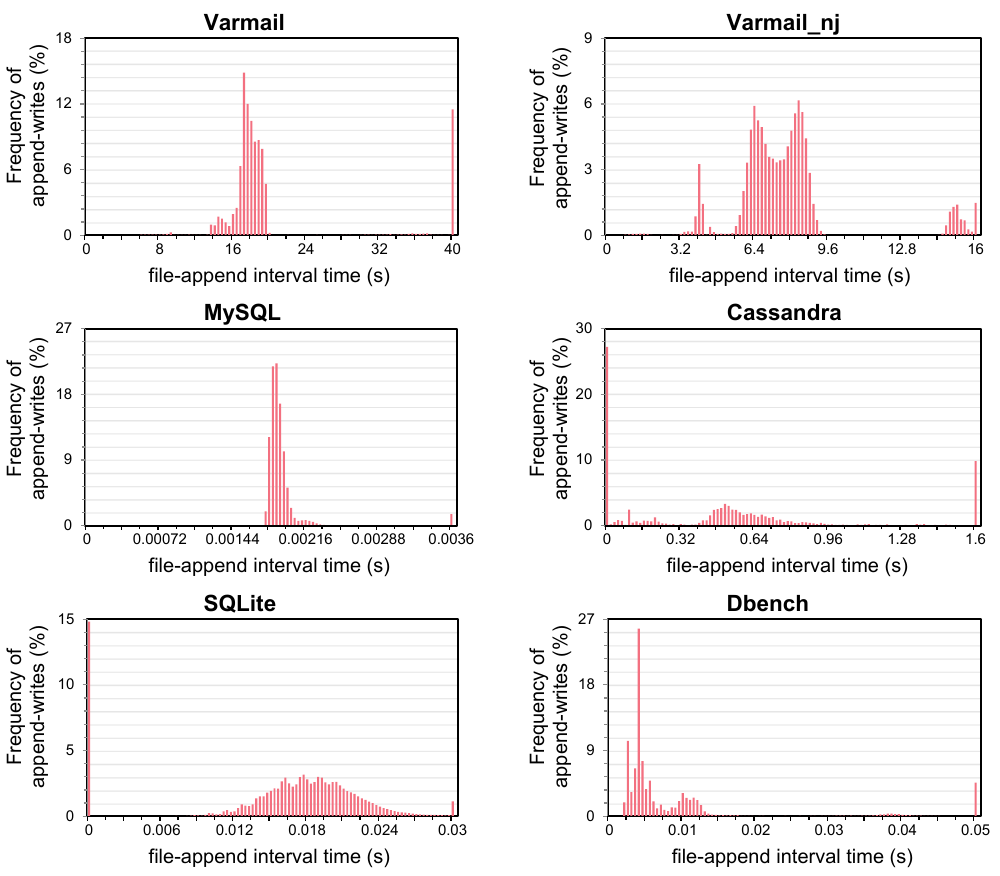
Figure 1. Interval distributions in various workloads.